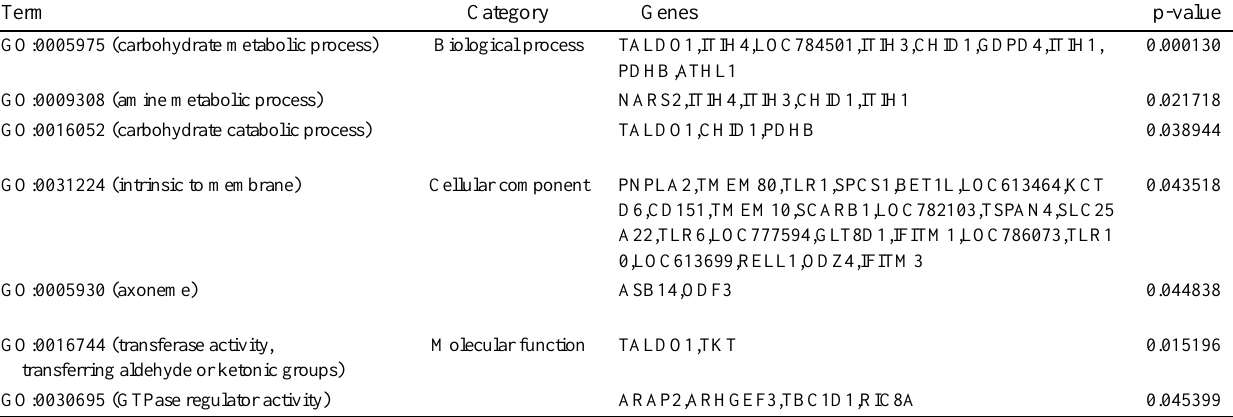
Table 4. Functional annotation of candidate genes within putative marbling QTL